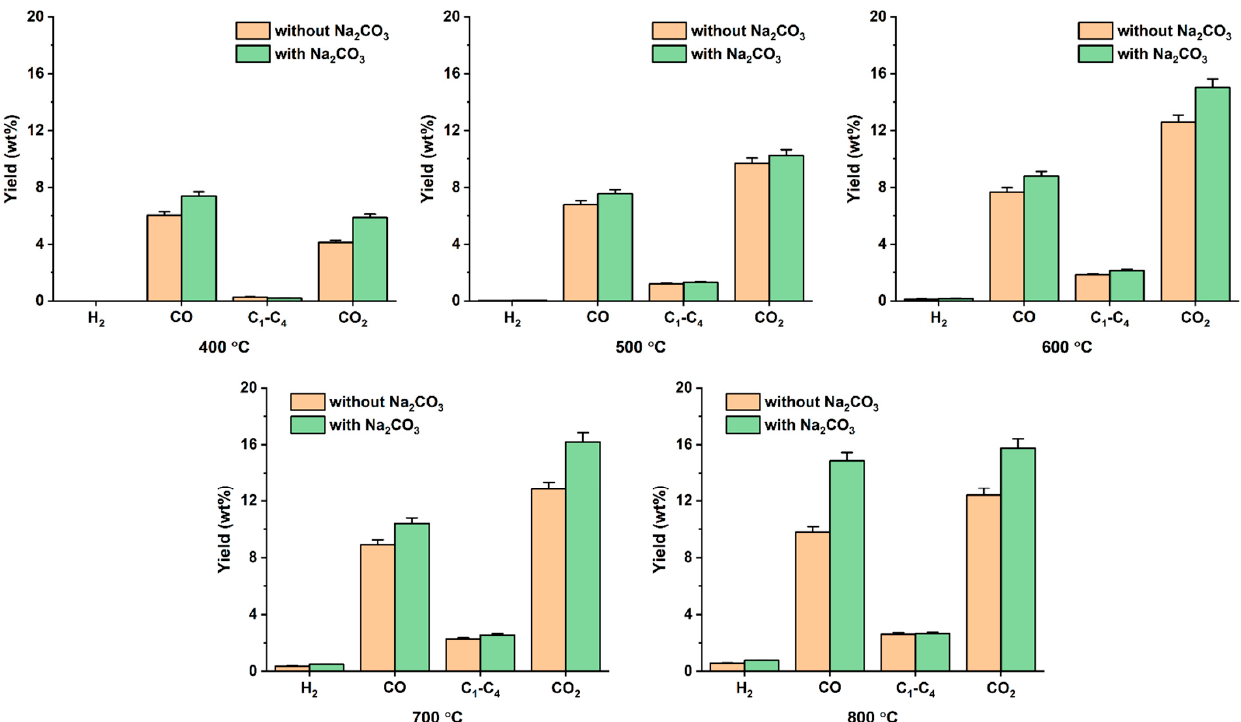
Figure 4. Non-condensable gas yields obtained by the pyrolysis of DJW with and without Na 2 CO 3 at varied pyrolysis temperatures. Average values of triplicate are reported with standard deviations given as error bars.